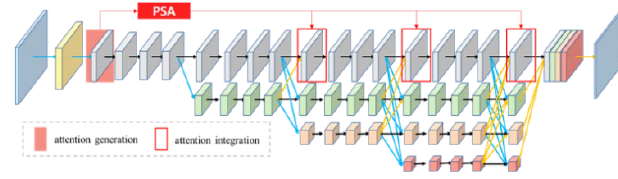
Figure 8. The workflow of PSA module applied in HRNet